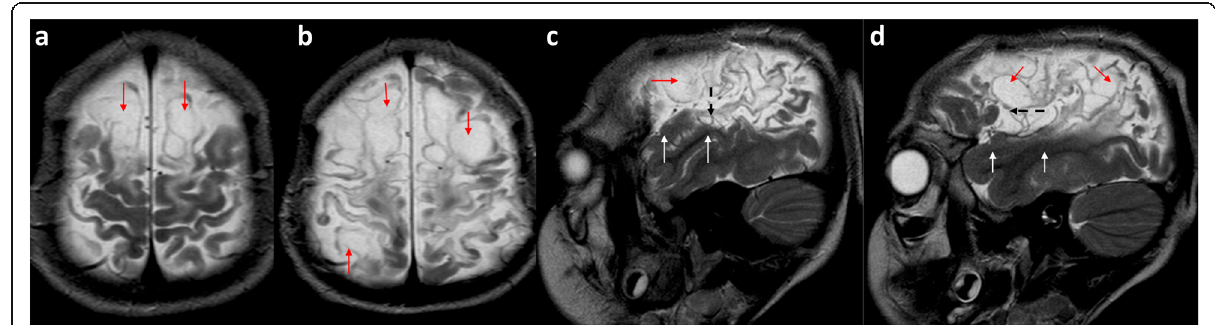
Fig. 16 a – d T2-weighted imaging of a 6-year-old boy who sustained a severe/catastrophic prolonged hypoxic-ischaemic injury at term gestation. Axial image just below the vertex ( a ) and sagittal image of the right lateral peri-sylvian region ( b ) shows extensive injury of the watershed continuum represented by multi-cystic encephalomalacia (red arrows). Of note, c and d are the extension of peri-Sylvian involvement into the posterior temporal lobe and extension of the parasagittal cystic encephalomalacia up to the Sylvian fissure (dashed black arrows) but with preservation of the superior temporal gyrus anteriorly seen on the sagittal images (solid white arrows)